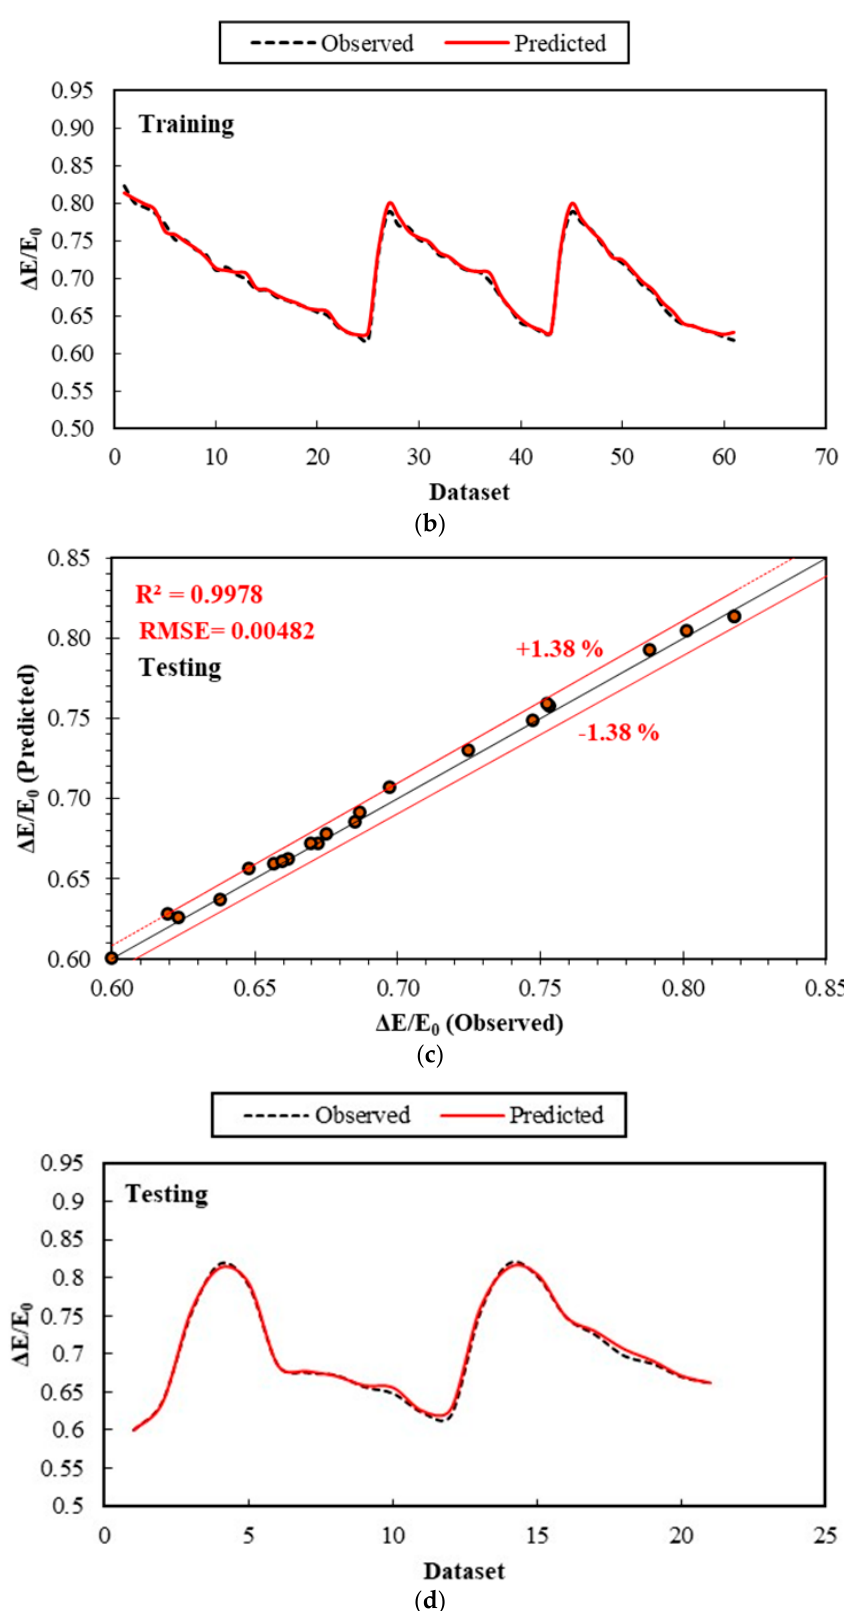
Figure 5. Comparison of the dependent and predicted energy dissipation values for the best model (model 3) in the first scenario. ( a , b ) Training; ( c , d ) testing.